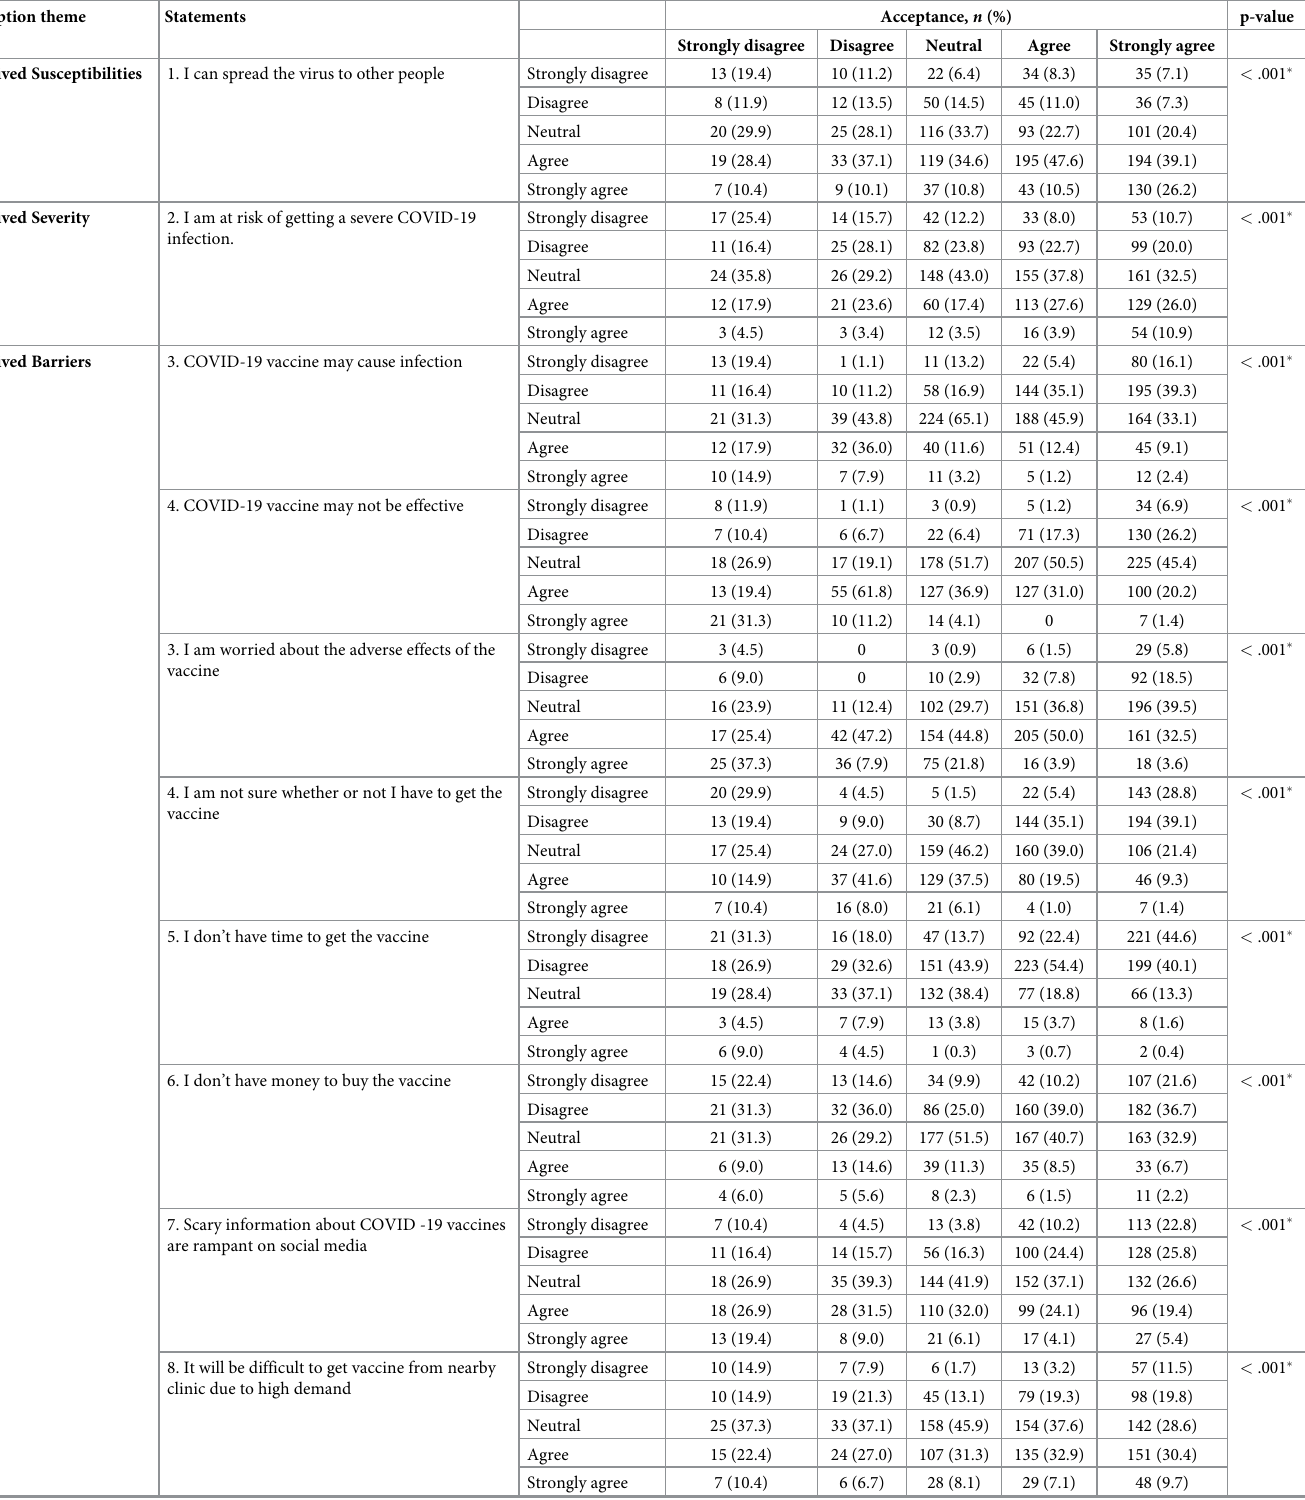
Table 7. Association between perception on susceptibilities, severity, barriers and benefits, and cues to action with acceptance towards COVID-19 vaccine (N = 1406). Perception